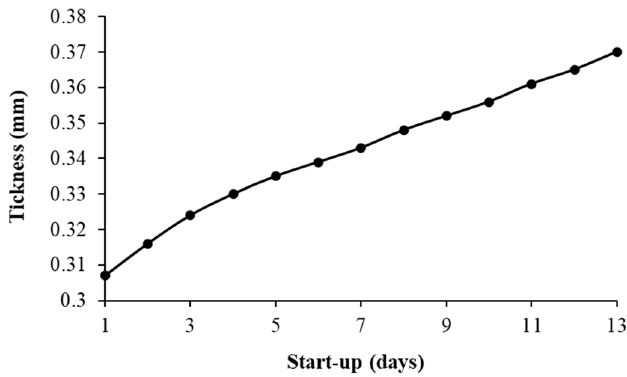
Figure 5. Biofilm development during the start-up process.